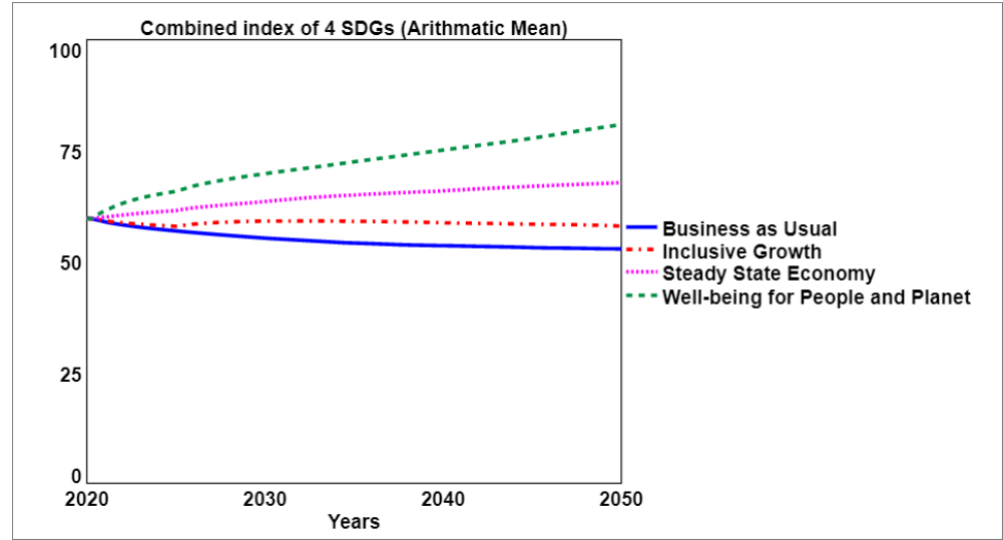
Figure 14. Combined index of SDGs in the four scenarios in Iran in the period 2020 to